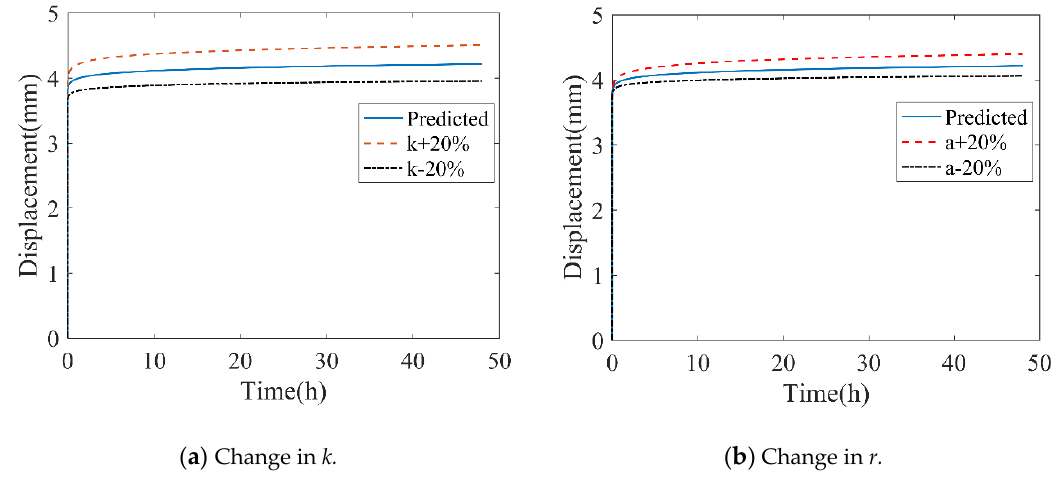
Figure 12. Effects of varying parameters in creep deformation responses. Figure 12. E ff ects of varying parameters in creep deformation responses.